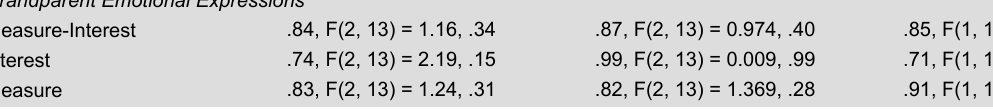
GP Gender EffectInfant Age EffectInfant Age*GP